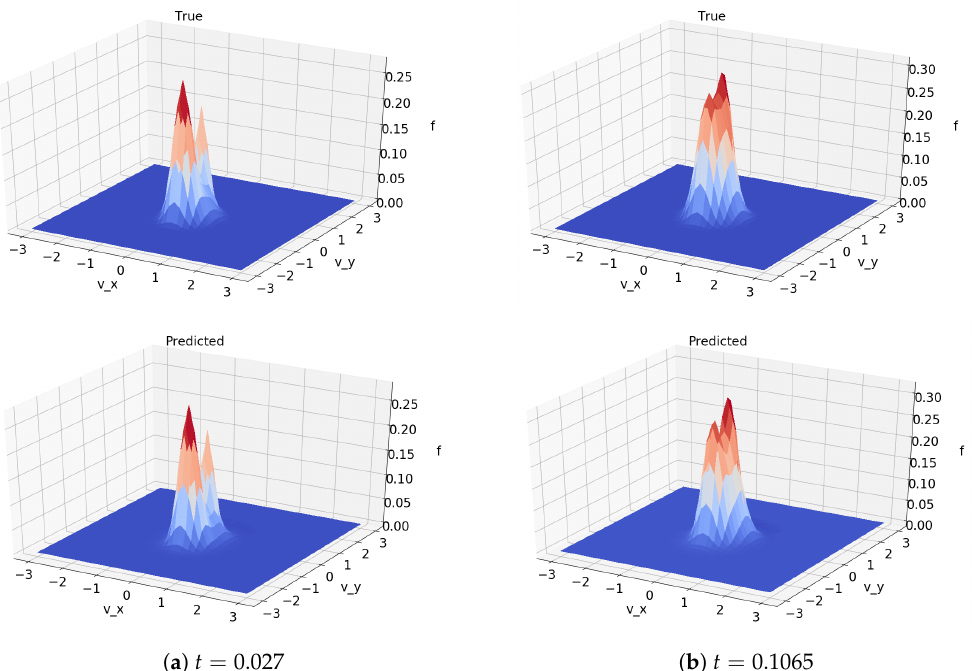
Figure 5. Comparison between solutions computed numerically ( top ) and using the machine learned model ( bottom ). Both comparisons were produced from the same initial data. Time stamps are normalized to the maximum time for which training data existed. These plots are of a single slice of the domain.